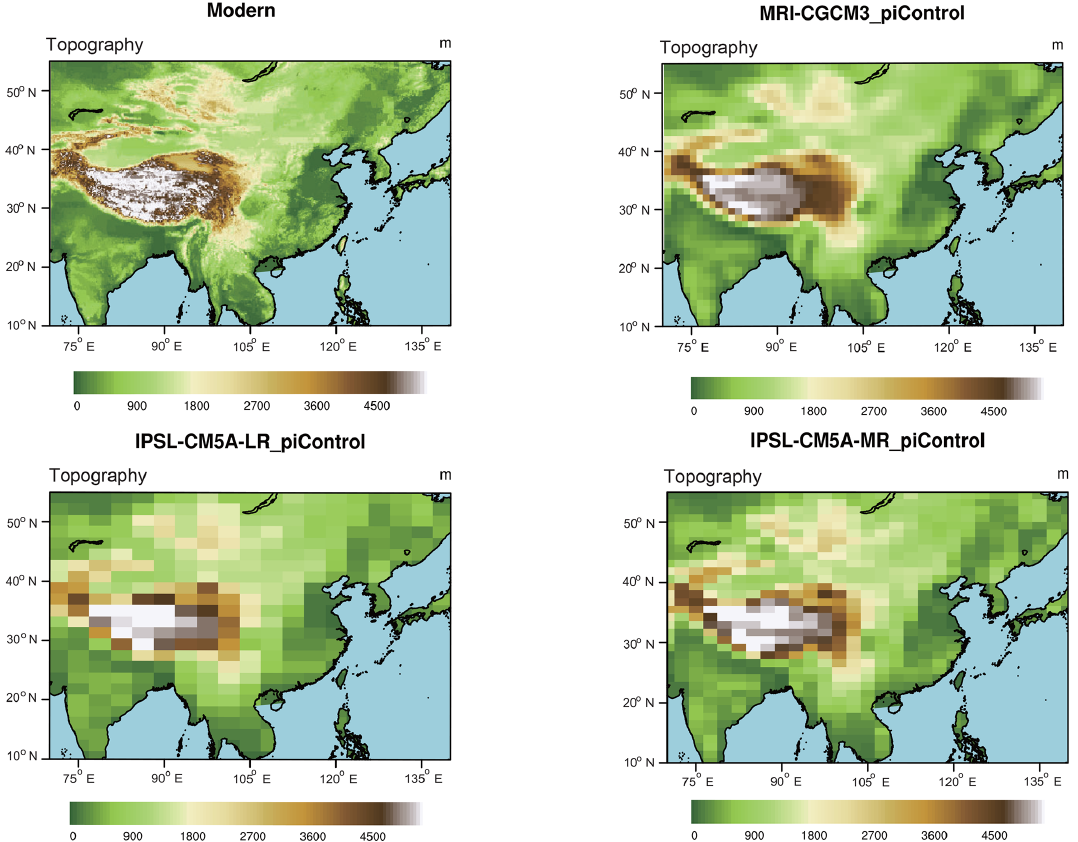
Figure 8. The topography comparison between models and